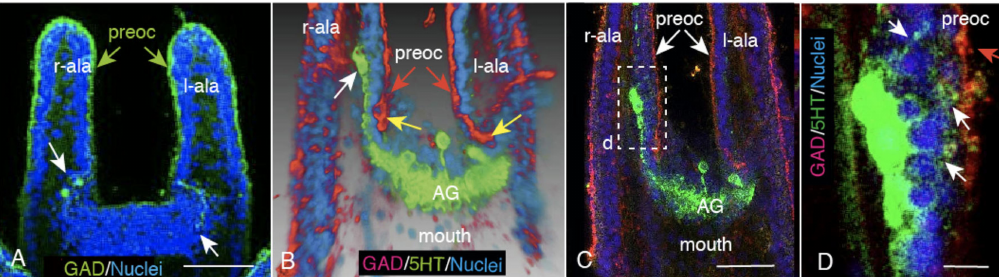
Figure 2. Circumoral CBAS interruption at the oral side of the upper lip field of 4aPL. ( A ) Confocal laser scanning microscopy (CLSM) of preoral CBAS (preoc) shows suspension at the upper lip field (white arrows). ( *B ) 3D-reconstructed image of (C) shows the oral side view around the serotonergic apical ganglion (AG, green). The terminal ends of the left- and right-preocs are shown with yellow arrows. White arrow; one of the bilateral arms from the apical ganglion. ( C ) CLSM of (B). The serotonergic apical ganglion (AG) extends an axon toward the right antero-lateral arm (r-ala) beneath the ectoderm. ( D ) Higher magnification of the rectangle (d) in (C) shows several cell processes from the perikaryon reaching to the preoral CBAS (white arrows). Red arrow: preoral CBAS. Scale bars = 30 µ m (A), 25 µ m (C), 5 µ m (D). * Refer to Supplemental Figure